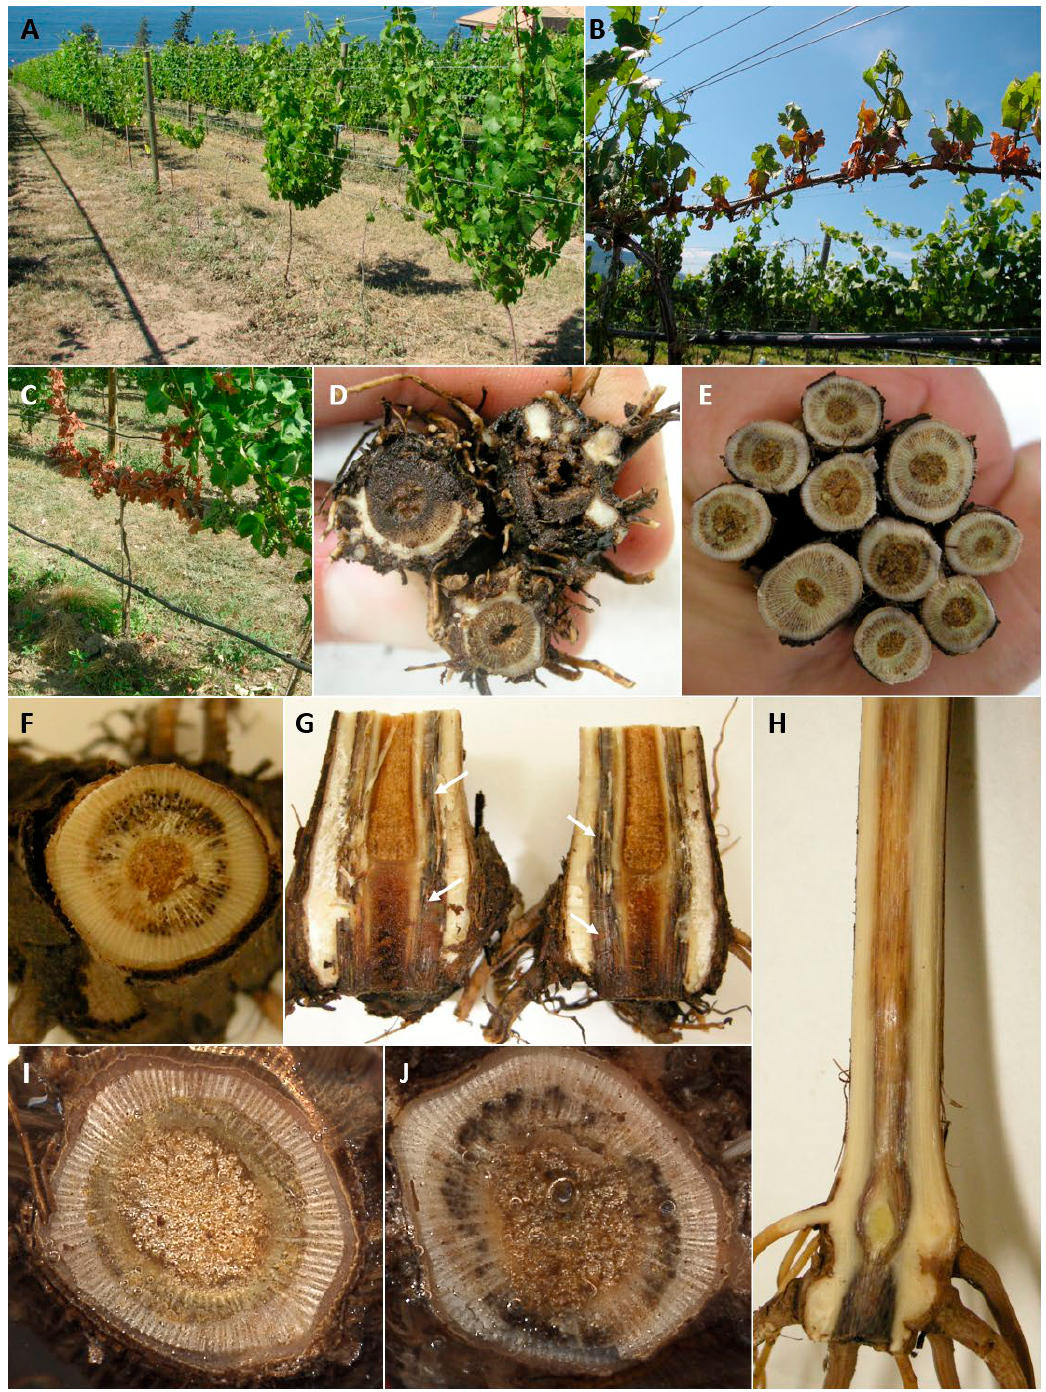
Figure 3. Decline of young vines caused by Petri disease and/or black foot. Overall symptoms in the field include poor vigour, leaf chlorosis, short internodes ( A and B ) and eventual or sudden collapse ( C ) during the growing season. Internal wood necrosis observed at the basal end of the rootstock ( D ) commonly associated with black foot. Tylosis plugged xylem vessels and necrosis observed at a graft union ( E ) and trunk base, usually associated with Petri disease in young vines ( F ). Longitudinal section of a ready-to-plant nursery vine showing vascular necrosis originating from the basal end of the rootstock ( G and H ). Phaeomoniella chlamydospora , Phaeoacremonium spp., Ilyonectria spp., and some Botryosphaeriaceae spp. can be isolated from asymptomatic ( I ) and symptomatic ( J ) wood tissues from nursery propagated mate- rial, which reveals their potential latent phases in